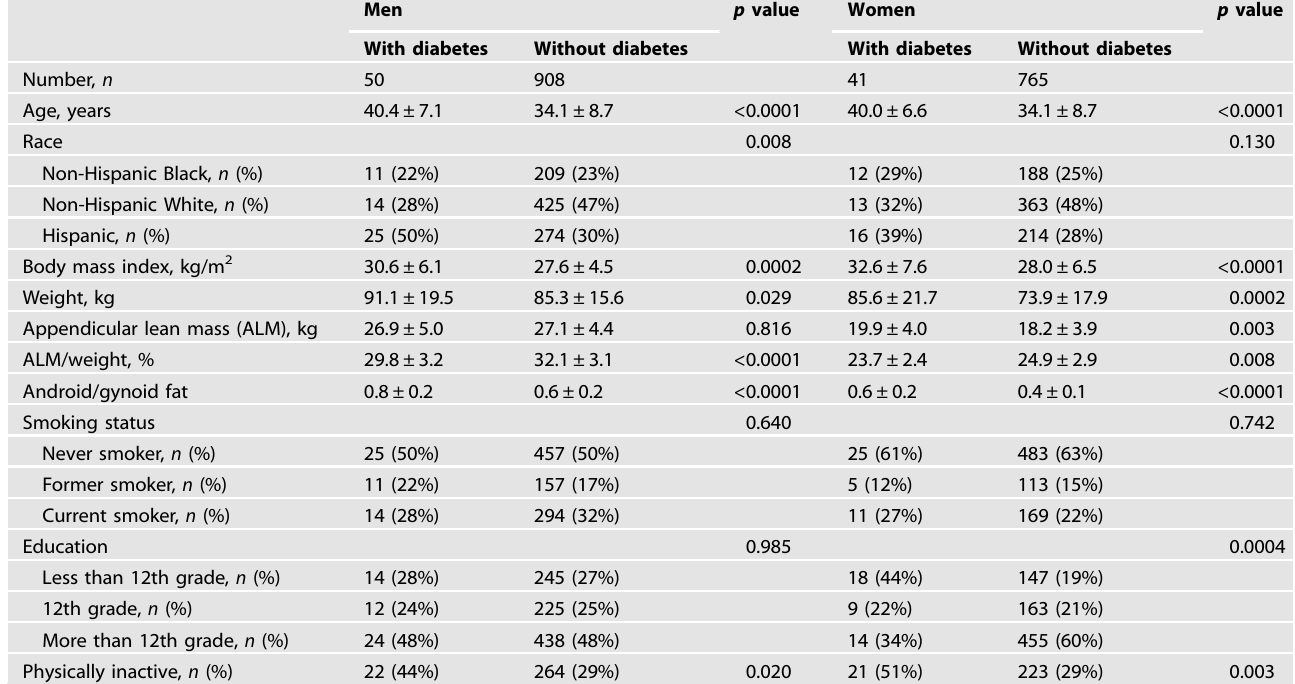
Table 1. Clinical characteristics (mean ±